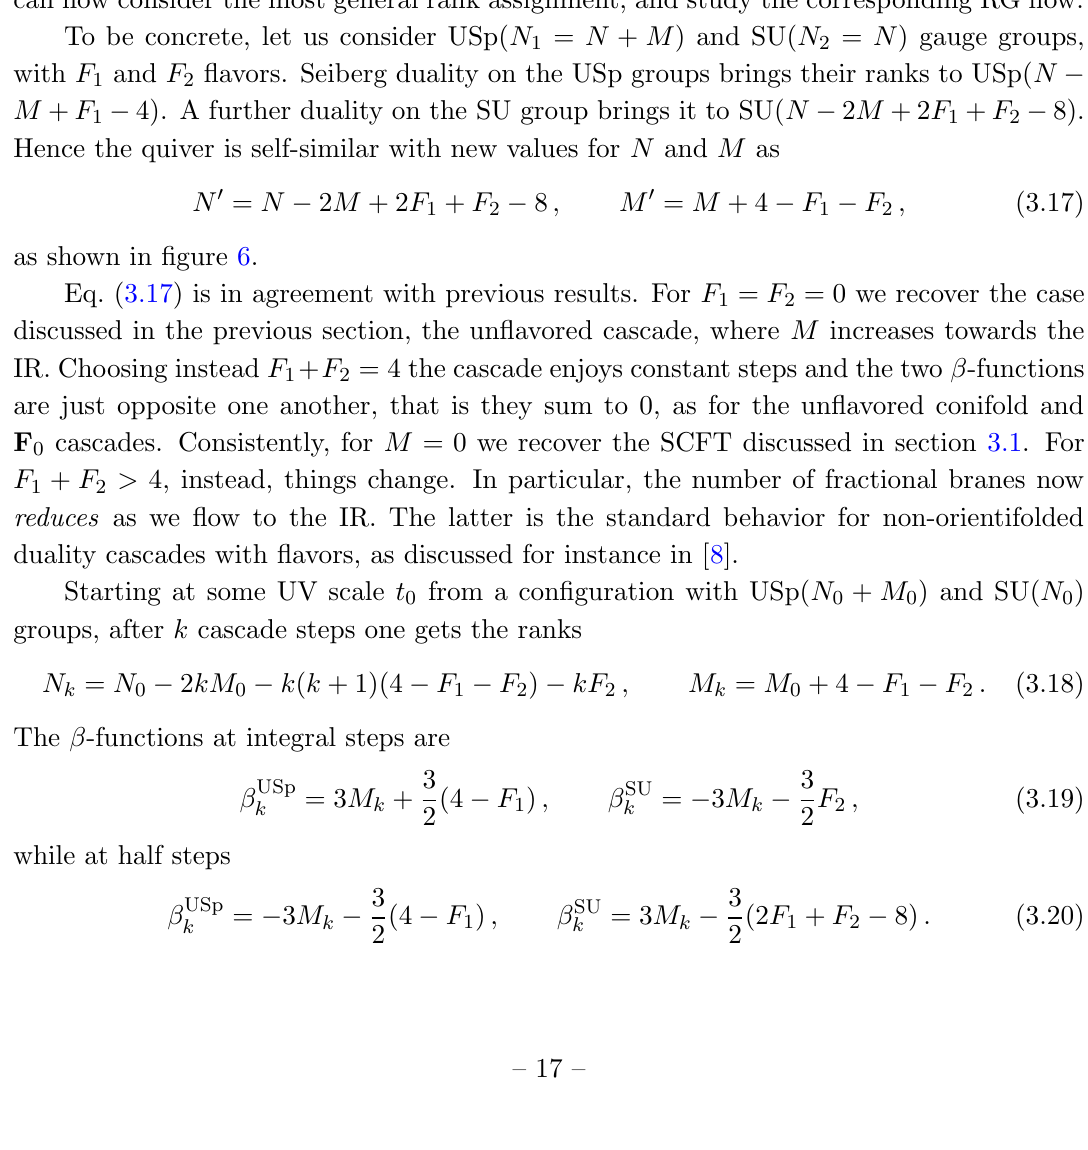
0 = (cid:10) theory with